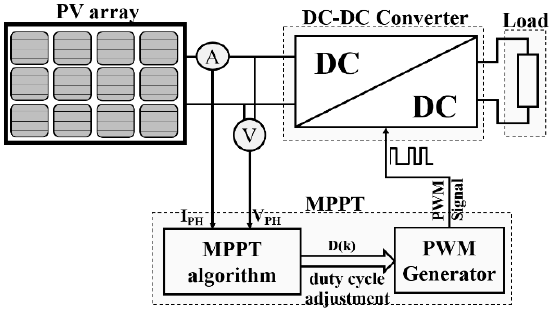
Fig. 3. PV system studied.